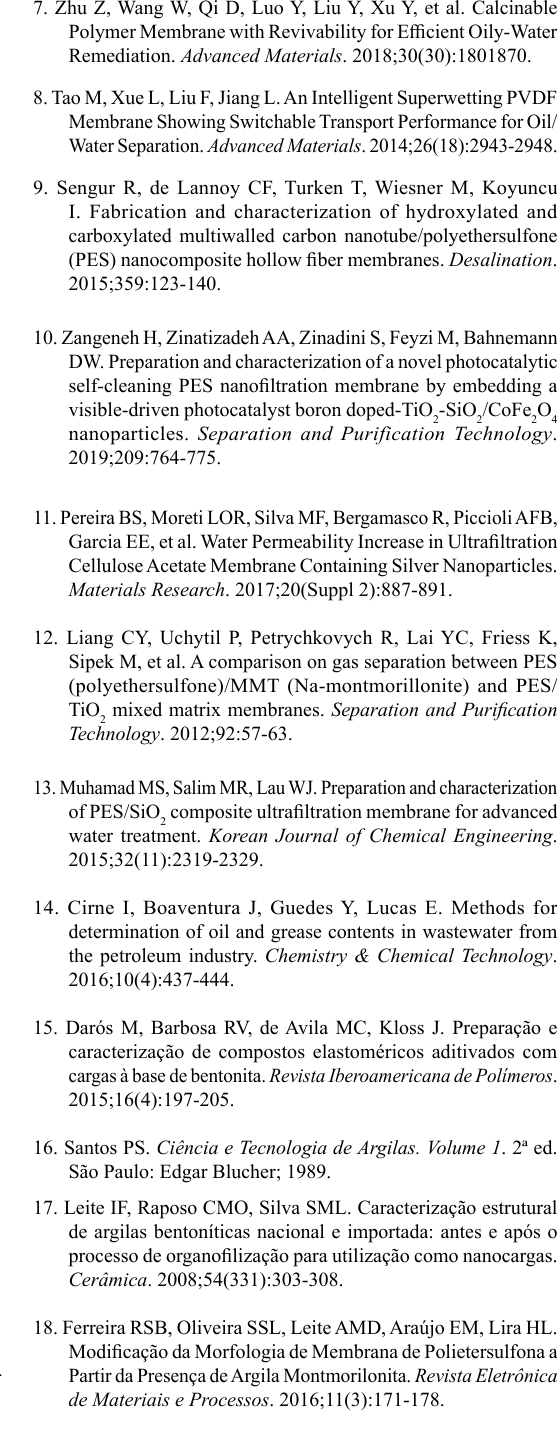
and yield calculated for Pure PES, PES + 3% MMT and PES + 3% CLNa membranes at a pressure of 1.0 bar. p